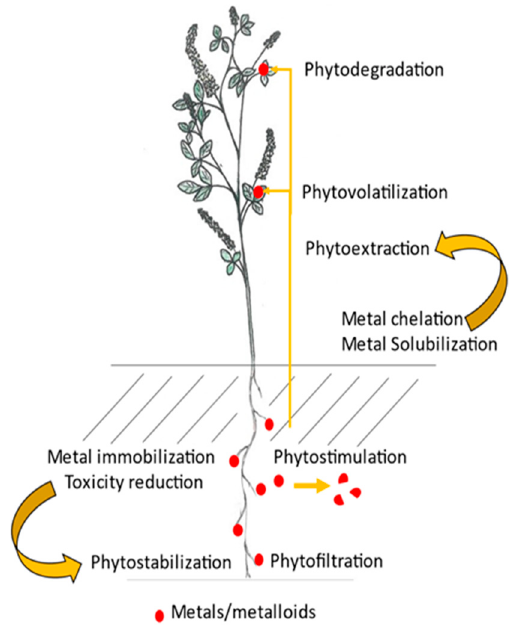
Figure 1. Processes used in phytoremediation of heavy metals—modified according to Ojuederie et al. [14].